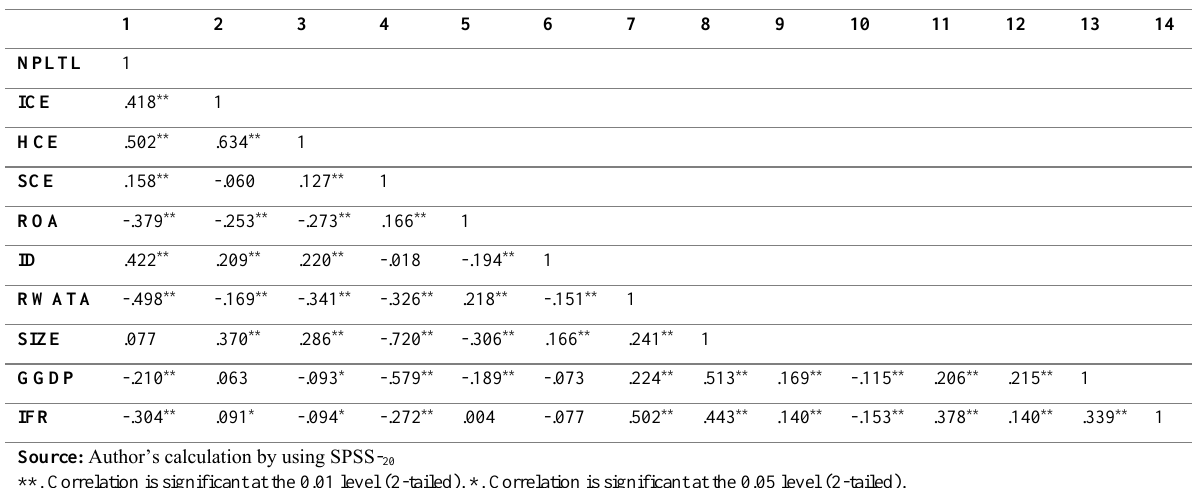
Table 3: Correlation